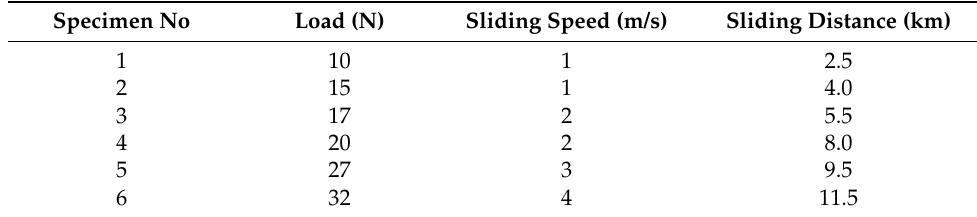
Table 4. Operational parameters selected.